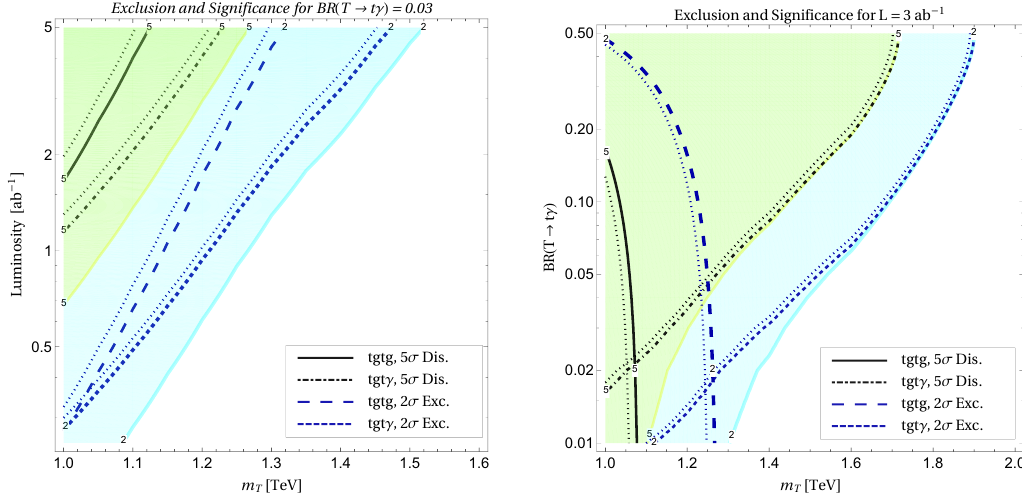
Figure 9 . (left) The required-integrated luminosity (in ab (cid:0) 1 ) as a function of m T for 5 (cid:27) discovery and 2 (cid:27) exclusion for BR( T ! t(cid:13) ) = 0 : 03 and BR( T ! tg ) = 0 : 97 as in eq. (4.2). (right) The minimum BR( T ! t(cid:13) ) needed for 5 (cid:27) discovery and 2 (cid:27) exclusion for a (cid:12)xed luminosity of 3 ab (cid:0) 1 as a function of m T while enforcing BR( T ! tg ) = 1 (cid:0) BR( T ! t(cid:13) ). Both panels are for spin- 1 partner. In both plots, the 5 (cid:27) discovery result for t (cid:22) tgg ( t (cid:22) tg(cid:13) ) is shown as the black-solid (black-dot- dashed) curve, while the 2 (cid:27) exclusion is shown as the blue-long-dashed (blue-short-dashed) curve. The green- and cyan-shade areas represent the combined 5 (cid:27) discovery and 2 (cid:27) exclusion, considering both t (cid:22) tgg and t (cid:22) tg(cid:13) channels. Dotted curves represent the corresponding results considering 20% upward (cid:13)uctuation in the estimation of the